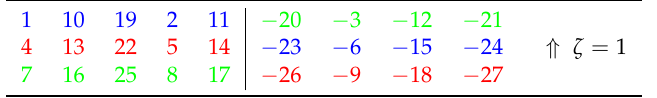
Table 8. WDT for a single-layer, three-phase bar winding with N = 27, m = 3 and p =